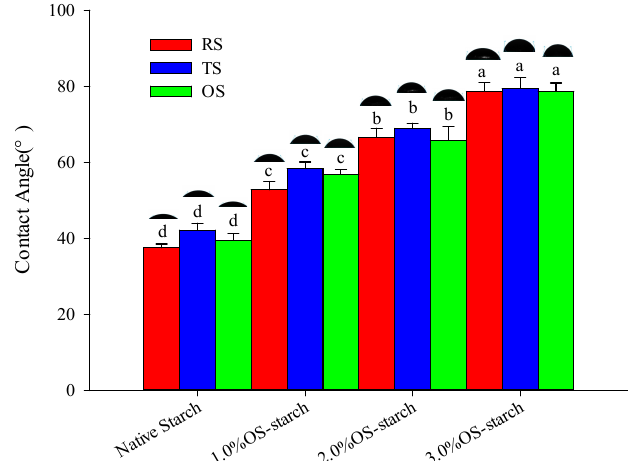
Figure 6. Contact angle of NS and OS-starch. Note: The data means average value ( n = 3); the different letters (a–d) means differ significantly ( p < 0.05), the same indicates that the difference is not significant ( p > 0.05).